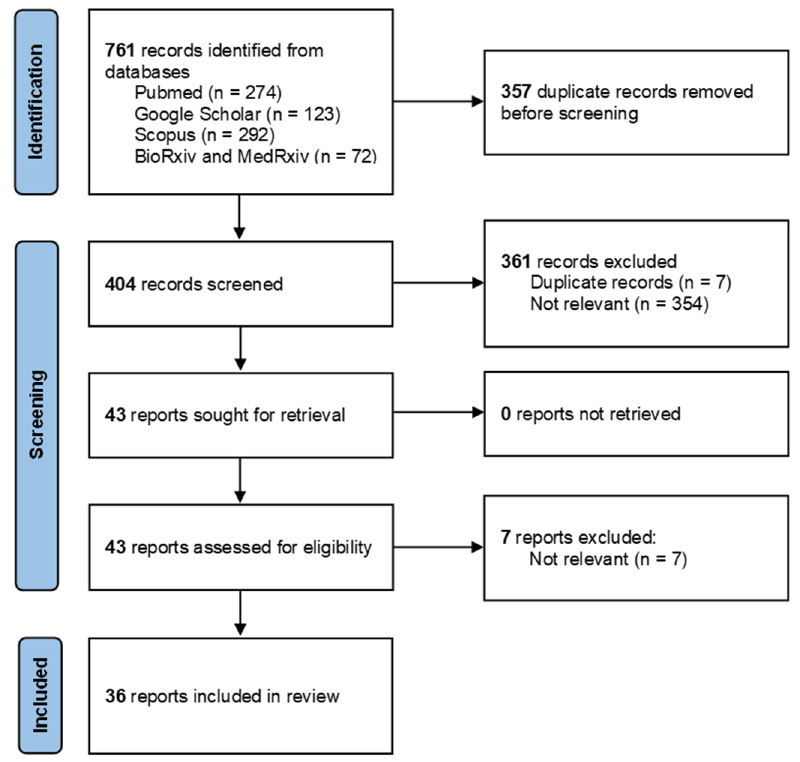
Figure 1. PRIMA flow diagram of article selection process.